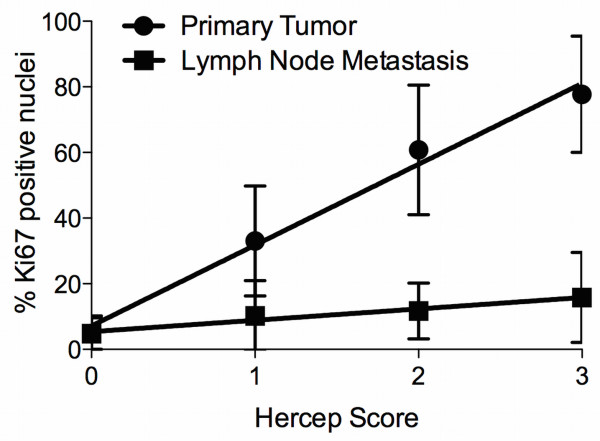
Linear regression analysis of Ki-67 positive nuclei (% of tumor tissue) in correlation to the Hercep-Score of the EpCAM staining for primary tumor tissue and lymph node metastasis. The slope of line for the primary tumor samples (n=163) was 24.64 [95% confidence interval (CI), 16.4 to 32.89] and the correlation coefficient (r2) 0.9881. For lymph node samples (n=88) the slope of the line was 3.466 [95% CI, 1.299 to 5.633] and the r2 0.9595. The dots/squares illustrate the mean value and the error bars the standard error of the mean (SEM). The slope of the lines deviated both significantly from zero (primary tumor: p=0.006; lymph node metastasis: p=0.02).